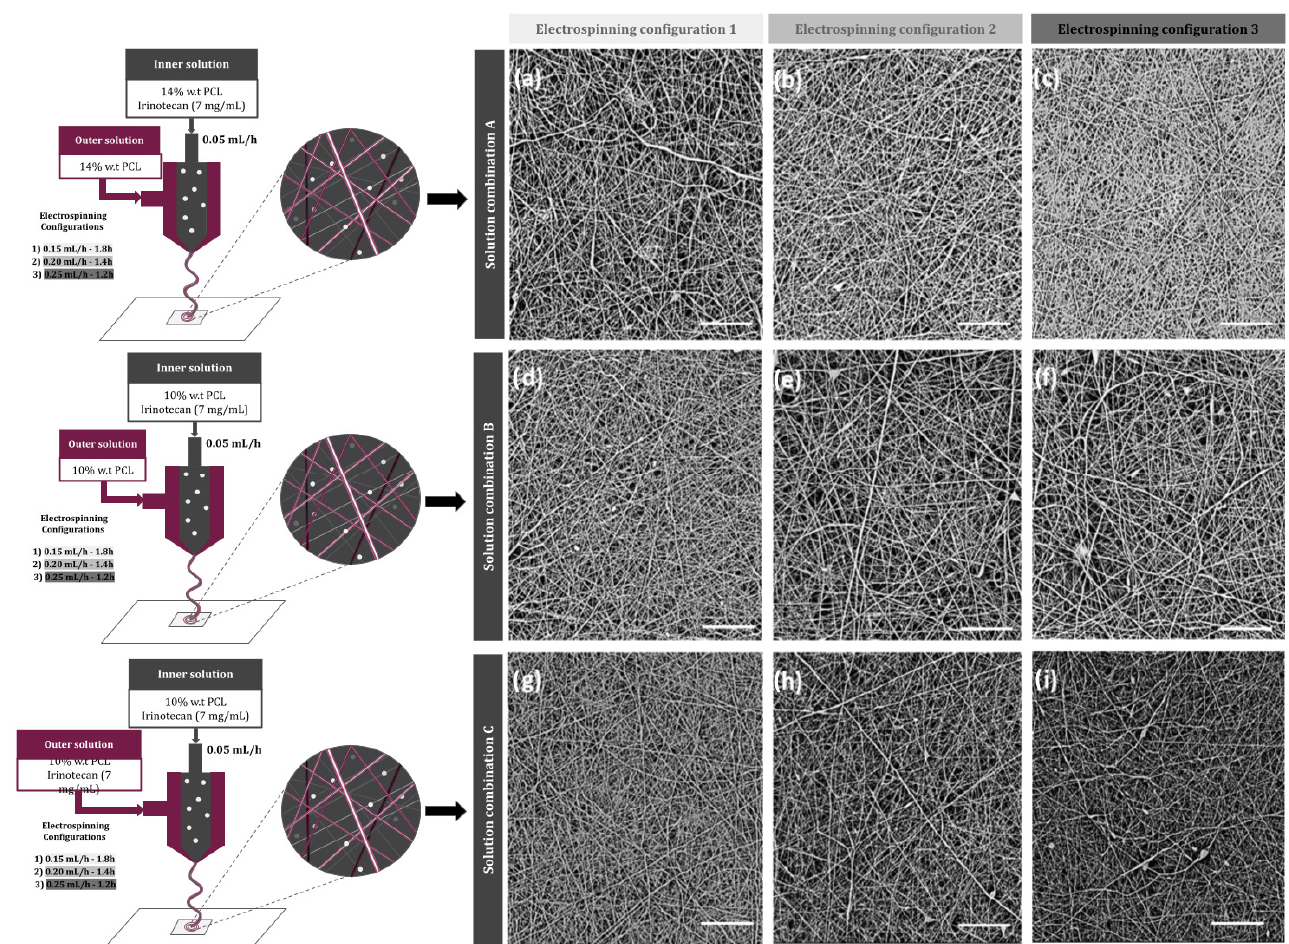
Figure 1. Schematic illustration of the designed electrospun nanofibers and SEM images of different membranes, according to their electrospinning parameters: ( a ) A1, ( b ) A2, ( c ) A3, ( d ) B1, ( e ) B2, ( f ) B3, ( g ) C1, ( h ) C2, and ( i ) C3. Scale bar: 20 µm.